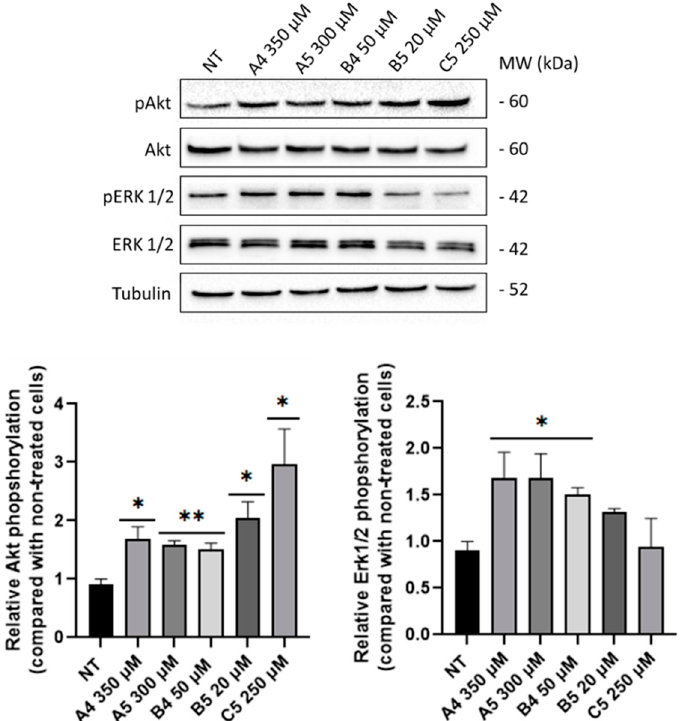
Figure 5. Akt and Erk1/2 phosphorylation levels in SUP-T1 cells at 4 h p.t. after GEs administration at the following concentrations: A4 = 350 µ M, A5 = 300 µ M, B4 = 50 µ M, B5 = 20 µ M and C5 = 250 µ M. Akt and Erk1/2 were analyzed through immunoblotting and relative densitometric analyses (lower panels). Phosphorylated proteins were normalized to the total proteins and housekeeping levels. Normalized values are reported on Y -axis as arbitrary units. Molecular weights (MW) in kDa and SEM bars are shown. Asterisks indicate p < 0.05 (*) or p < 0.01 (**), compared with non-treated (NT) control cells (ANOVA One-Way). The experiments were performed on four independent biological replicas.